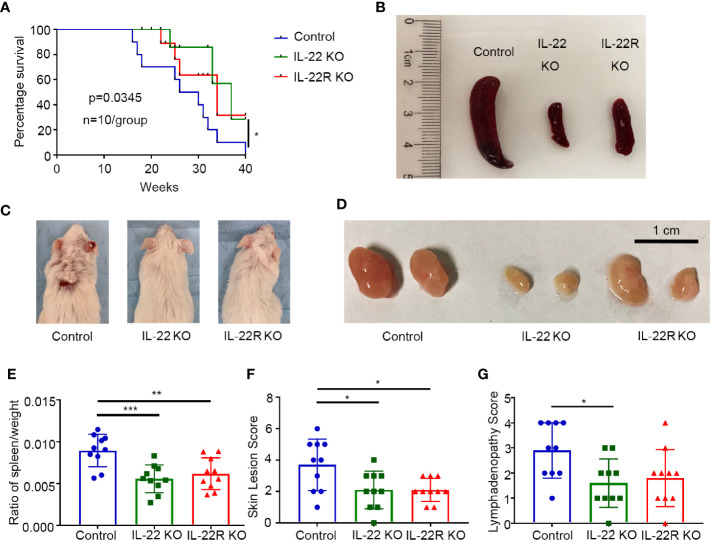
IL-22 shortened survival and promoted systemic illness in lupus-prone mice. (A) Survival curve of control, IL-22 KO, and IL-22R KO mice (n=10/group) over 10 months. (B–D) Representative images of spleen, skin, and lymph node from control, IL-22 KO, and IL-22R KO mice (24 weeks old mice). (E) The ratio of the spleen/weight, (F) skin lesion score and (G) lymphadenopathy score were compared between 24-weks-old control, IL-22 KO, and IL22-R KO mice. Skin lesions were scored by gross pathology using a grade of 0–6 (0 = none; 1 = mild, < 2 cm; 2 = severe, ≥2 cm, scored the snout, ears, and intrascapular separately and added). Lymphadenopathy (cervical, brachial, and inguinal) was graded as 0–4 (0=none; 1=small, one site; 2=moderate, two sites; 3=large, three sites; and 4=very large, four sites or more). Data were expressed as mean ± SD, and were representative of three independent experiments. One way ANOVA was used for comparison among all groups (*P < 0.05, **P < 0.01, ***P < 0.001).